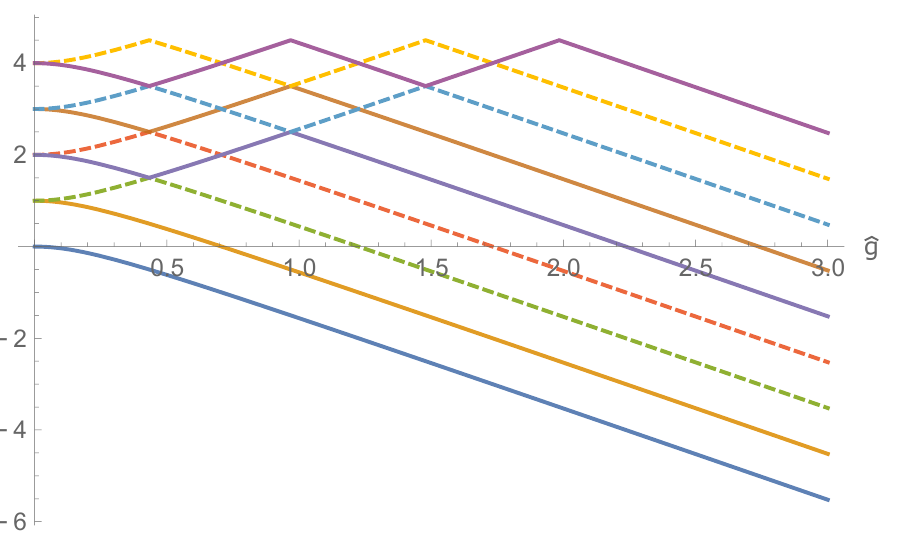
Figure 15 . The (cid:12)rst several states at (cid:30) = 0. For each level the dependence of (cid:1) on the coupling alternates between (5.24) and (5.25) before taking the form (5.24) at large